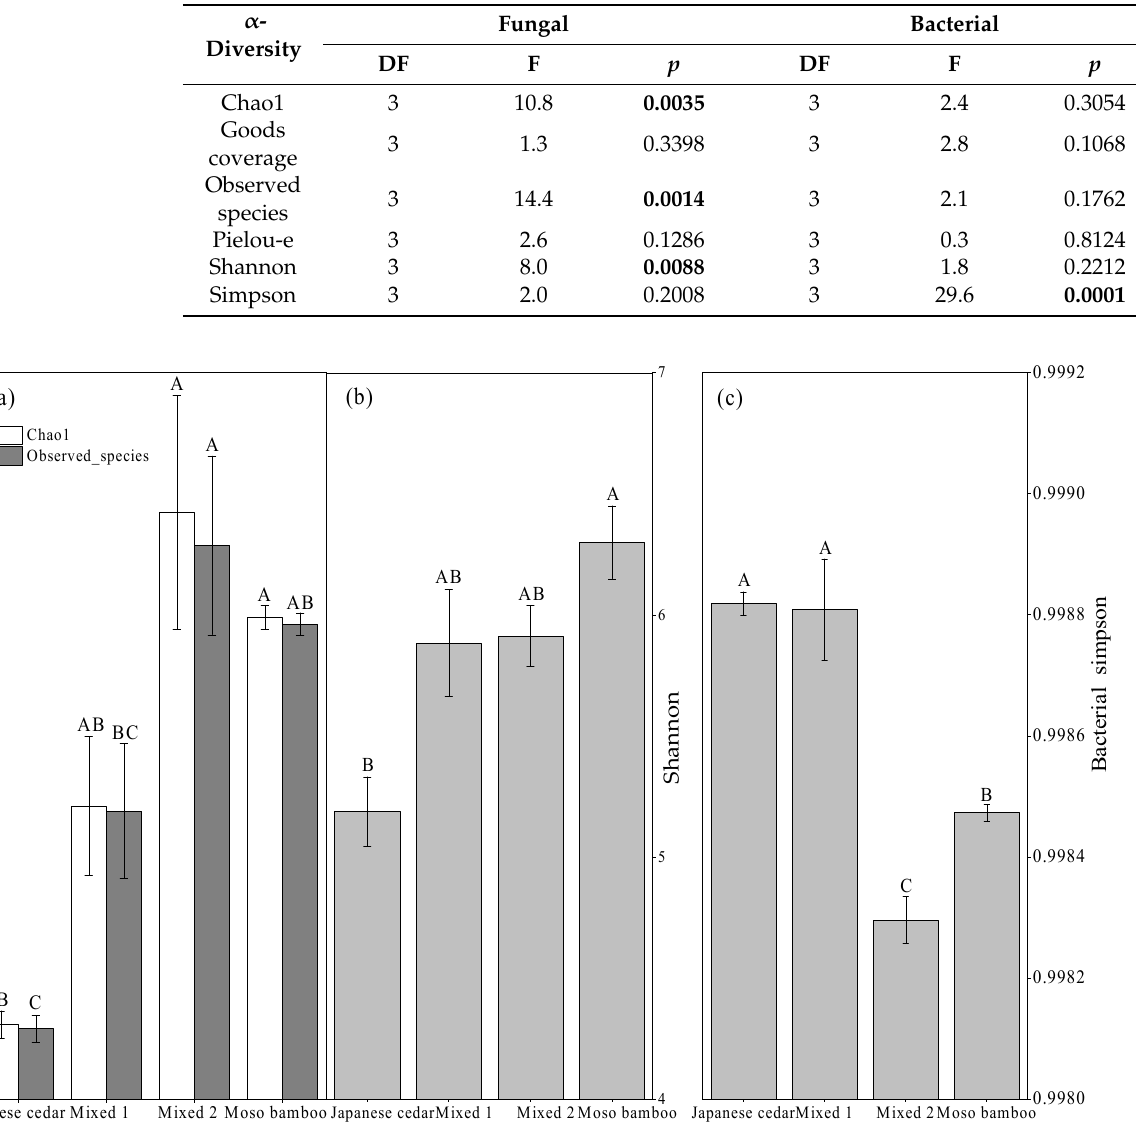
Table 3. Effects of moso bamboo expansion on soil microbial fungi and bacteria α -diversity in ANOVAs. Results with significant p values are shown in bold.